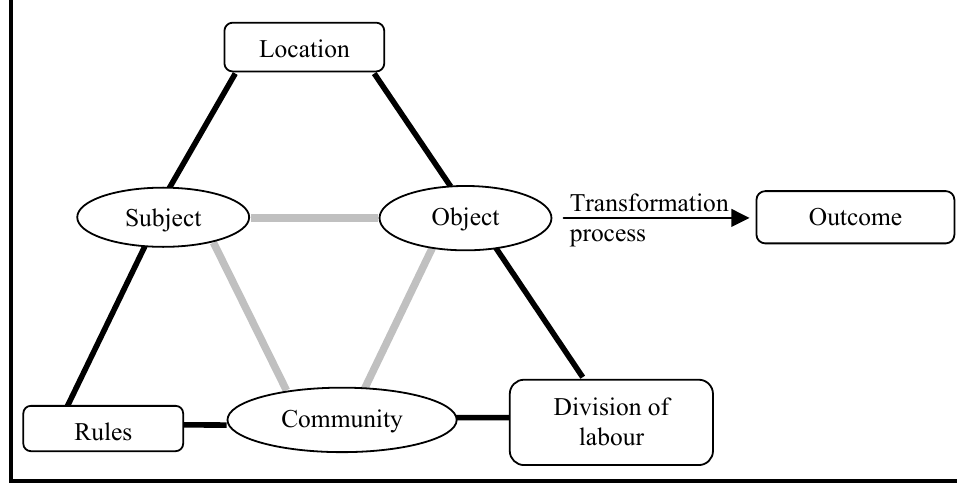
Figure 3. Framework for analysing mobile